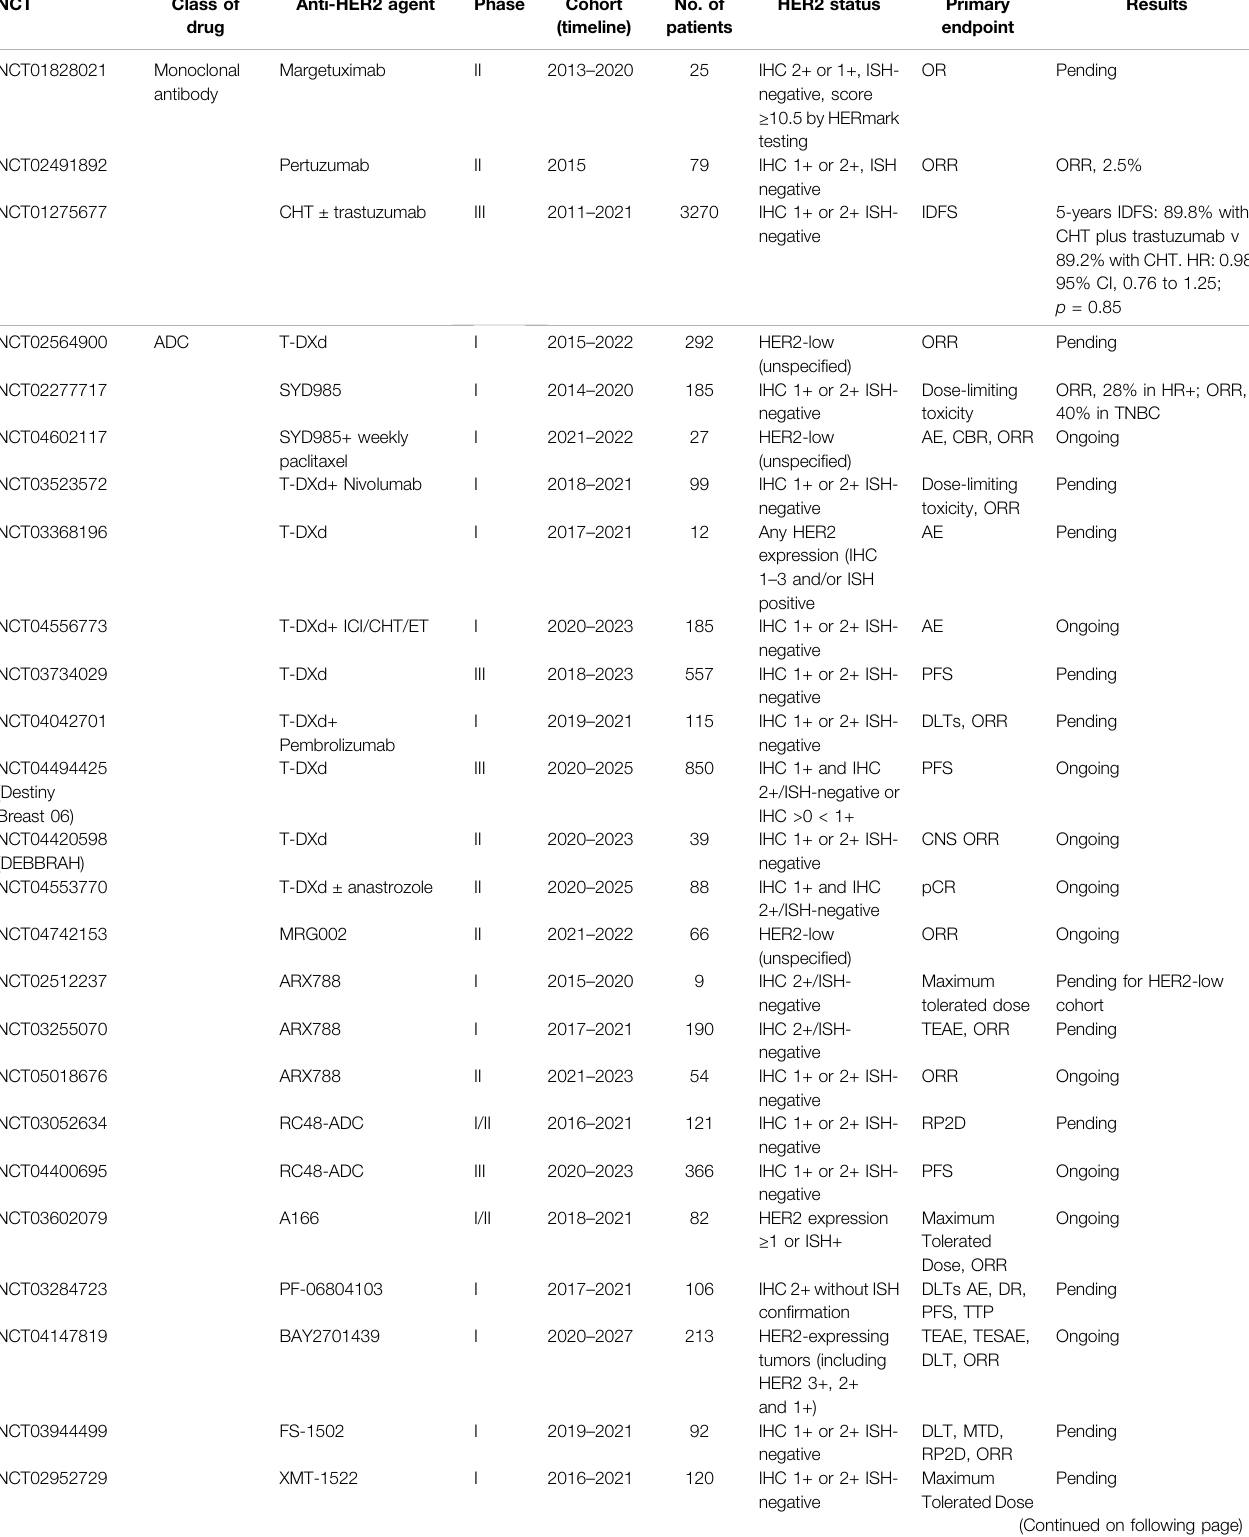
TABLE 1 | Ongoing and recently completed clinical trials using HER2-targeting agents in HER2-low and/or “ ultra-low ” breast cancer